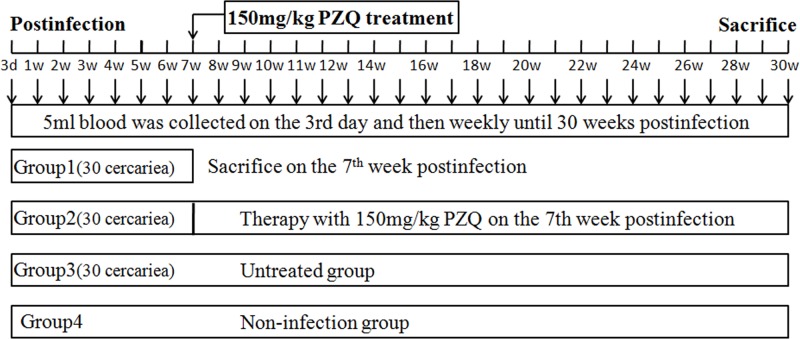
Schematic representation of rabbit infections and blood sample collections.